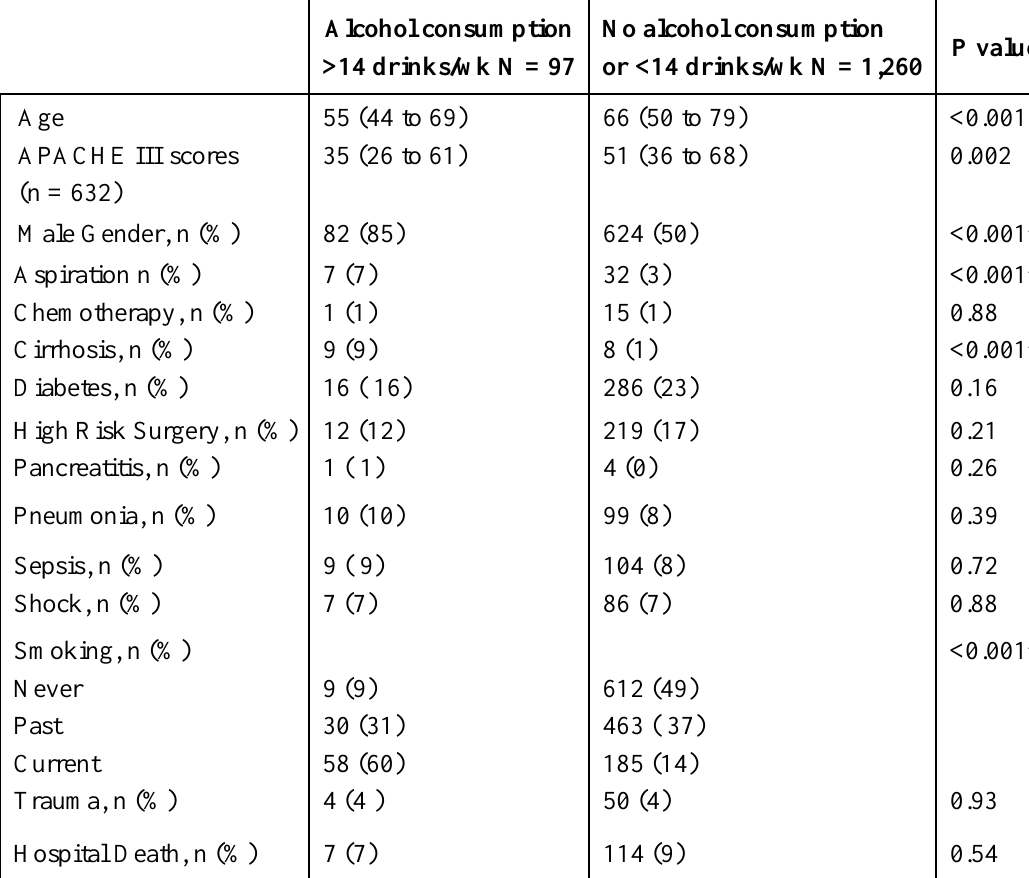
Table 1. Differences in alcohol consumption and clinical characteristics of the